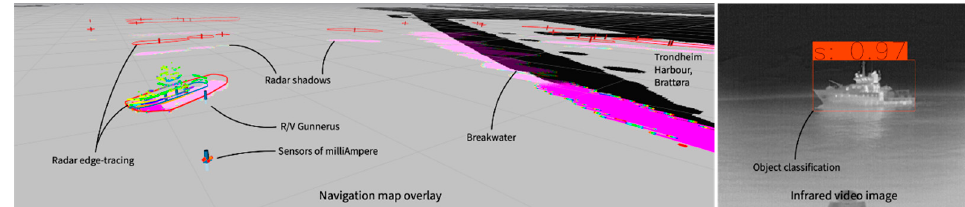
Figure 8. Visualization in Robotic Operating System (ROS) helping a developer of milliAmpere understand sensor fusion (image credit Øystein Helgesen, used with permission).